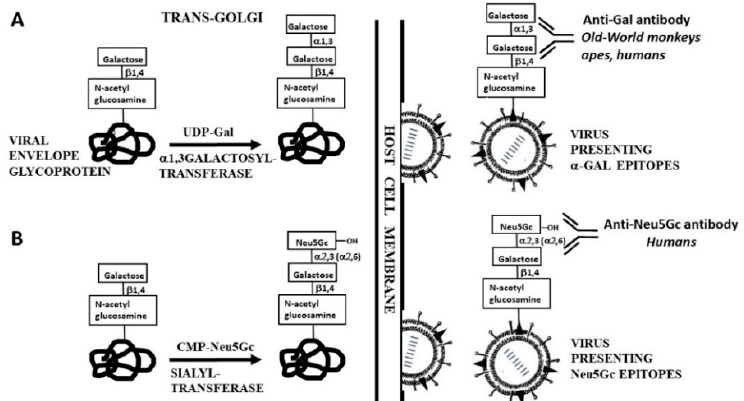
Figure 1. Synthesis of α -gal epitopes ( A ) and N-glycolyl-neuraminic acid (Neu5Gc) ( B ) on glycans of enveloped virus glycoproteins. The “capping” of the glycans occurs in the trans-Golgi compartment of host-cells and is mediated by α 1,3galactosyltransferase and α 2,3 and α 2,6 sialyltransferases, using UDP-Gal and CMP-Neu5Gc as high-energy sugar donors, respectively. The hydroxyl of Neu5Gc differentiating it from Neu5Ac is indicated. Viral glycoproteins are assembled on cell membranes to form the virus envelope, followed by budding of the virus. Antibodies binding to these glycans and the species producing them are indicated. Modified from ref. [16].